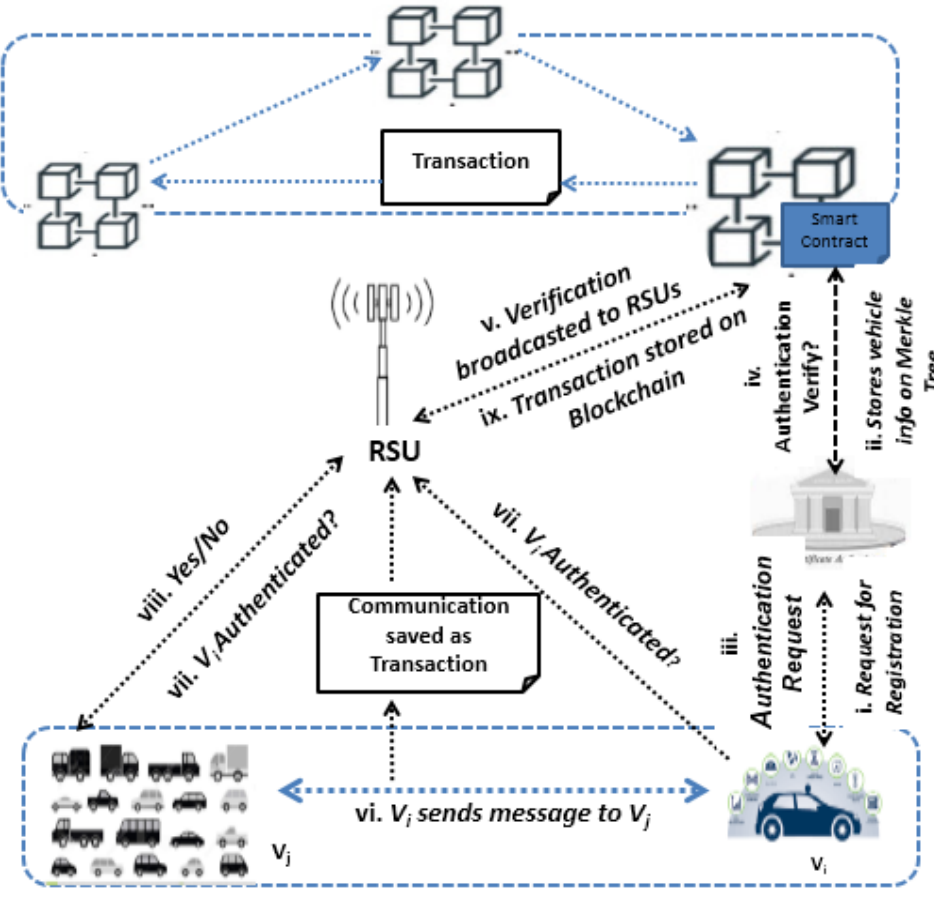
Figure 2. Security and privacy using zk-SNARK over blockchain-proposed architecture. Table 1. List of Acronyms.